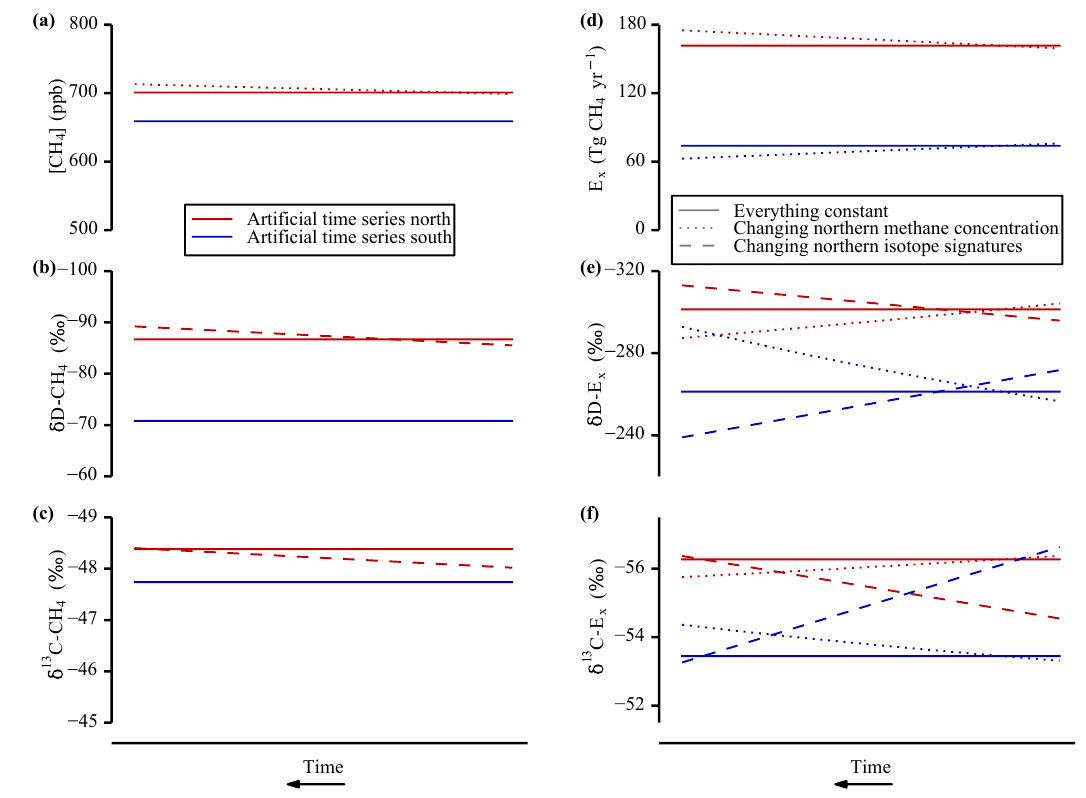
Figure 2. Artificial time series and inversion results. Artificial tropospheric [CH 4 ] (a) and stable isotope time series (b, c) used as input for the box model inversion. The calculated mean hemispheric CH 4 emission strengths (d) and their isotopic signatures (e, f) show the dependence on the different input parameters. Three experiments are performed: all input values constant (solid lines), all constant but the northern tropospheric CH 4 isotope values varied (dashed lines), and all constant but [CH 4 ] varied (dotted lines). To be consistent with the wording in the text, time runs from right to left. Note the inverted y axes in panels (b) , (c) , (e) , and (f)